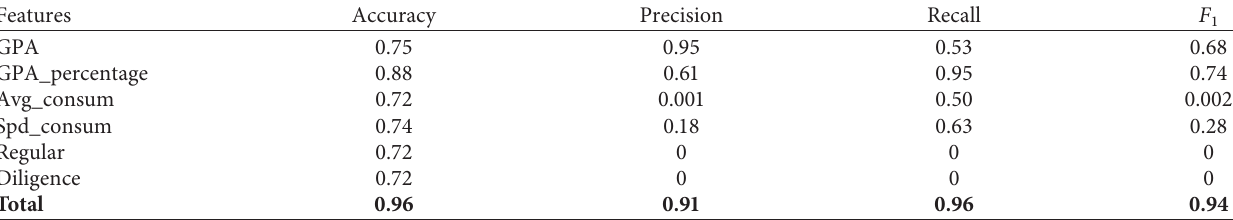
Table 19: Performance of different features on logistic